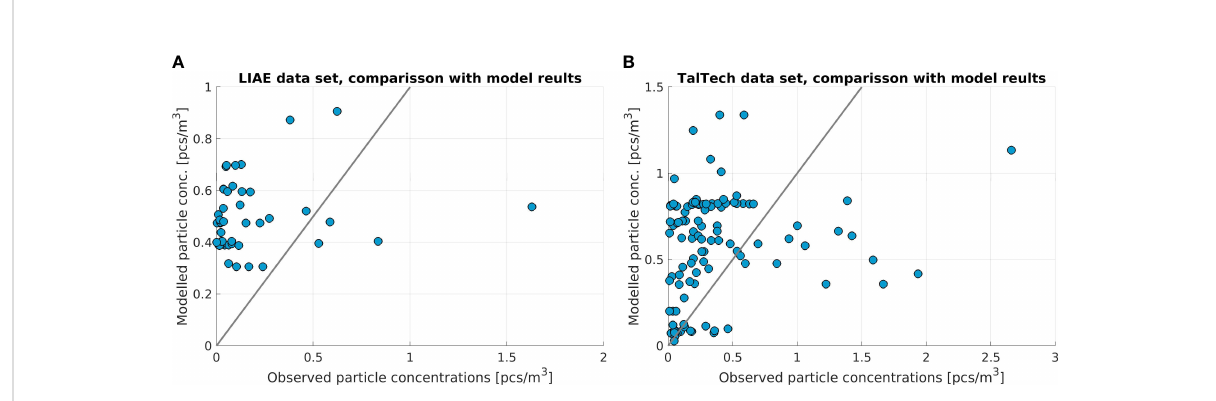
FIGURE 8 Scatter plot, i.e., a model – observation diagram, for the LIAE data set in June – September 2018 (A) and TalTech data set in 2016 – 2020 (B)